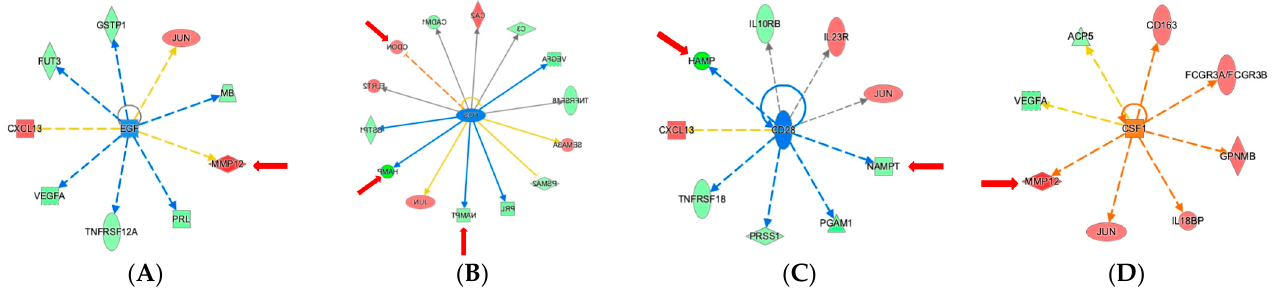
Figure 6. Upstream Regulator Analysis shows significant effects of surgical myectomy on proteins regulated by ( A ). EGF, ( B ), FOS, ( C ), CD28, and ( D ) CSF1. Red indicates upregulation and green denotes downregulation in ‘post’. Proteins are coded by shape; square—cytokine, vertical rhombus—enzyme, horizontal rhombus—peptidase, trapezoid—transporter, ellipse—transmembrane receptor, and circle—other. Links are color-coded as red—leads to activation, blue—leads to inhibition, yellow—findings inconsistent with state of downstream protein, and black—effect not predicted. Red arrows indicate proteins of particular interest and relevance.